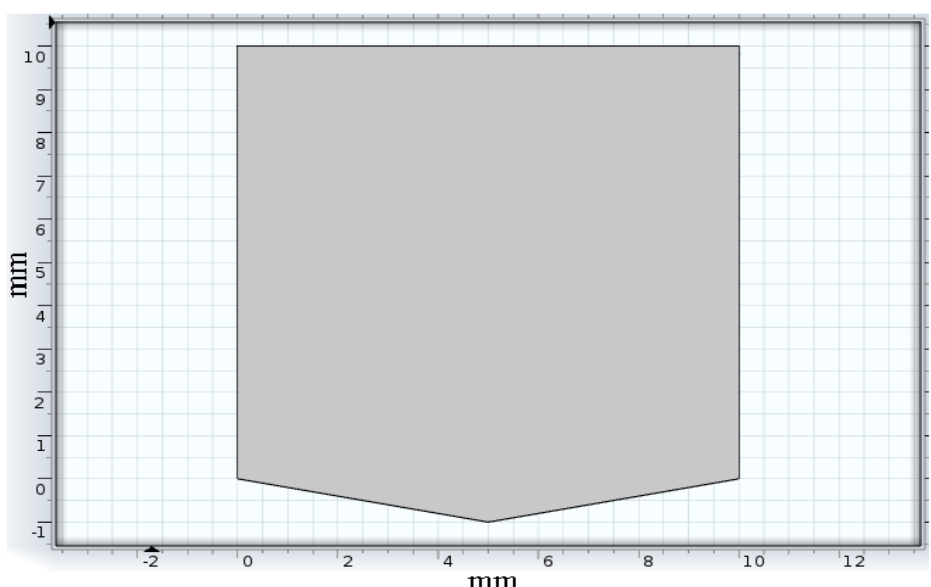
Figure 4. Substrate model.